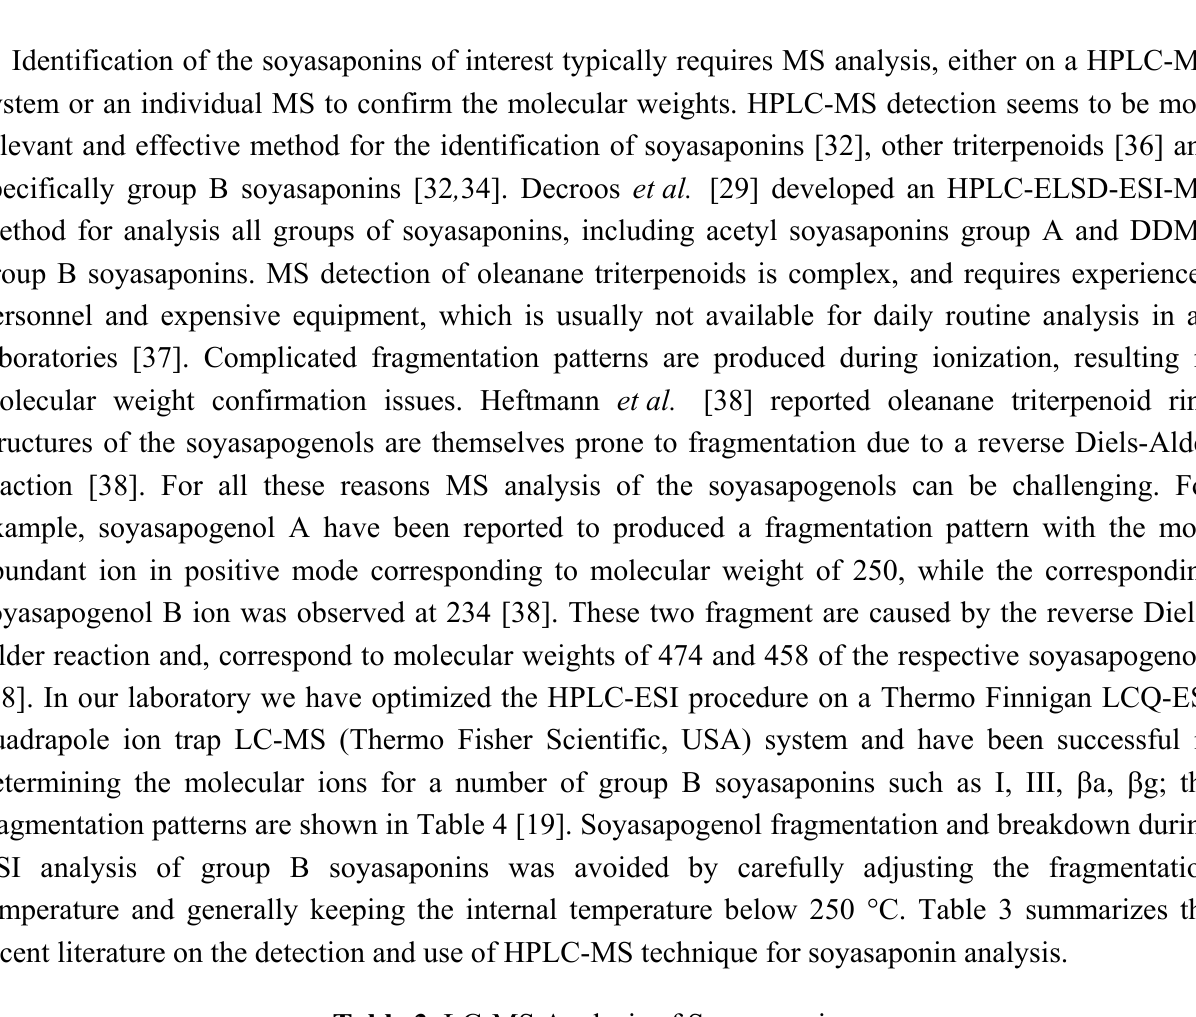
Table 3. LC-MS Analysis of